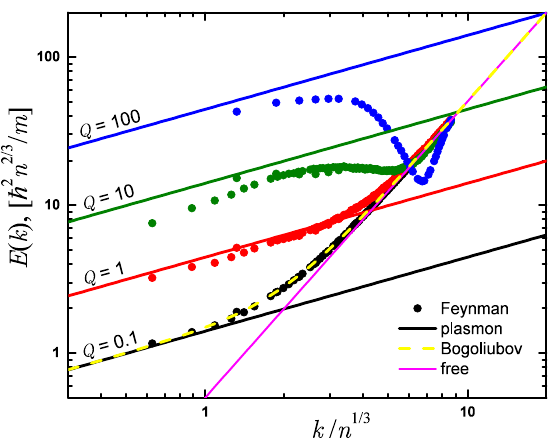
Figure 6. Upper bound for the excitation spectrum E ( k ) on a double logarithmic scale as provided by Feynman relation (48) by using the data presented in Figure 5. Symbols, Monte Carlo results; solid thick lines, k 1/2 plasmon relation; dashed line, Bogoliubov excitation spectrum (18); thin solid line, free particle ¯ h 2 k 2 /2 m energy. Units of ¯ h 2 n 2/3 / m are used for the energy and n 1/3 for the